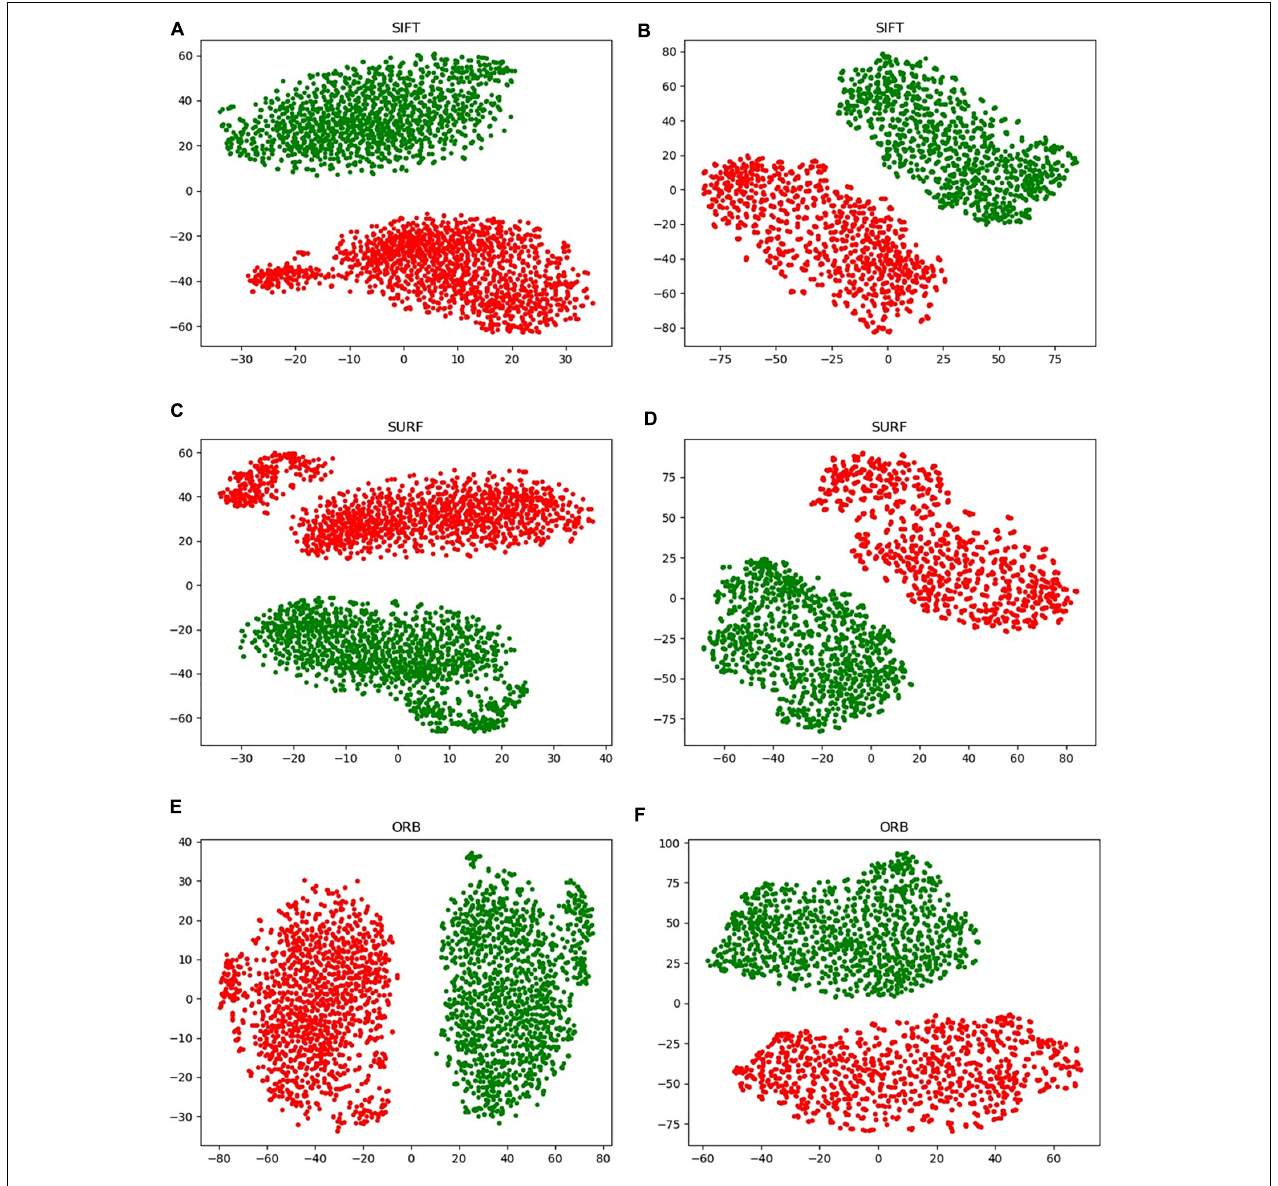
FIGURE 12 | Visualization of the handcrafted features through T-SNE. (A,C,E) Virtual data augmentation of SIFT, SURF, and ORB, respectively; (B,D,F) real image augmentation of SIFT, SURF, and ORB,